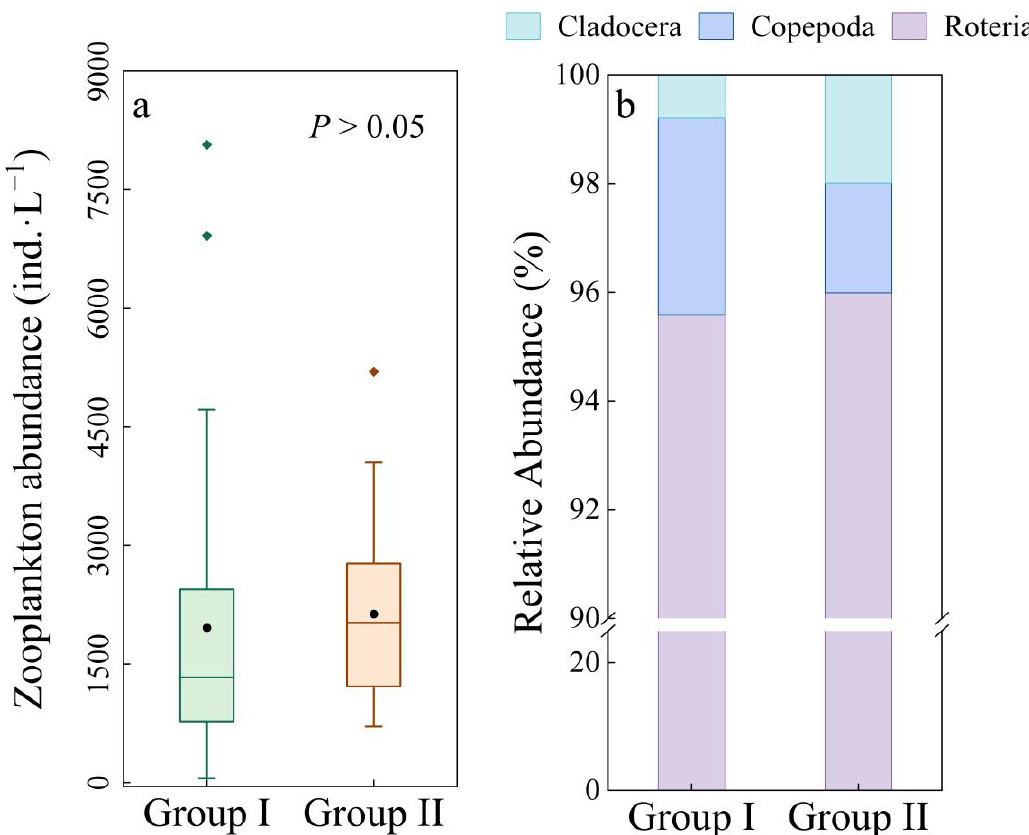
Figure 3. Zooplankton abundance ( a ) and relative abundance ( b ) in Group I (NH 3 -N < 1.03 mg·L −1 ) and Group II (NH 3 -N ≥ 1.03 mg·L −1 ).